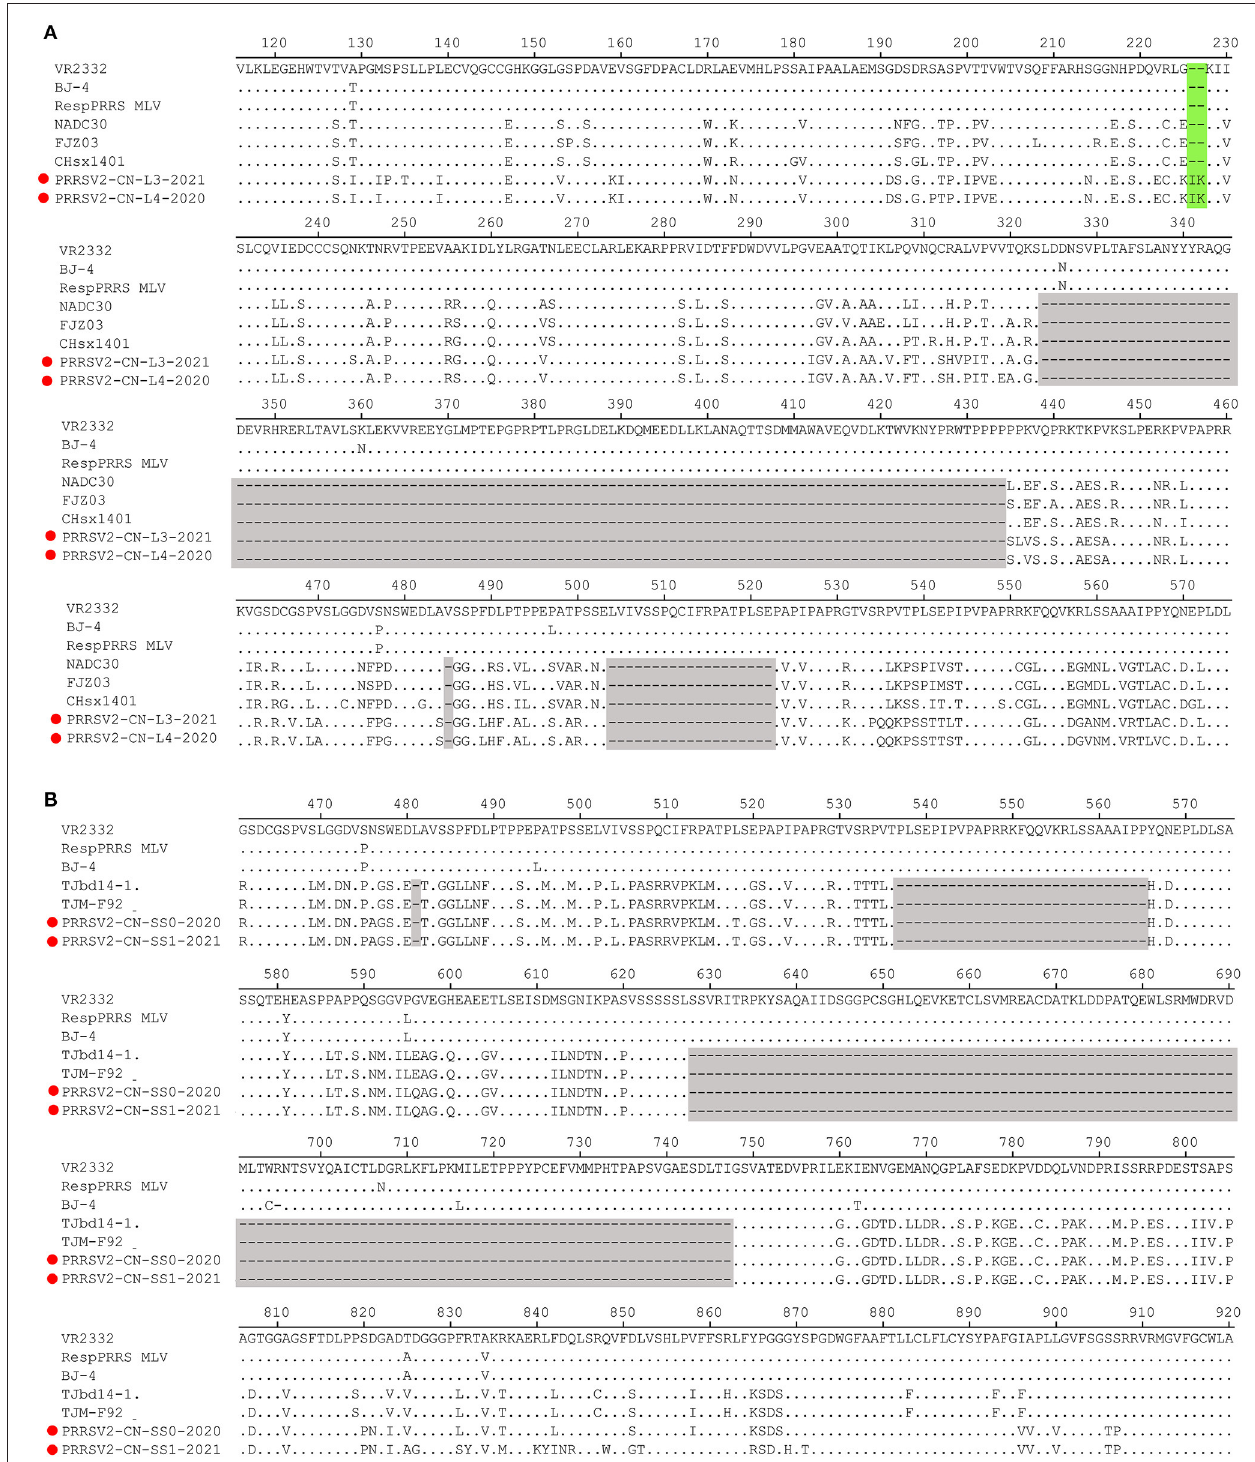
FIGURE 2 | Amino acids alignment for Nsp2 of the four PRRSV isolates with representative strains. (A) The 131-aa discontinuous deletions (aa324–434, aa485, and aa504–522) highlighted in gray boxes show the deletion signature of PRRSV2/CN/L3/2021, PRRSV2/CN/L4/2021, and NADC30-like strains. Additional 2-aa insertion in PRRSV2/CN/L3/2021 and PRRSV2/CN/L4/2021 is marked in the green box. (B) The 150-aa discontinuous deletions (aa481 + aa537-566 + aa628–747) highlighted in gray boxes show the deletion signature of PRRSV2/CN/SS0/2020, PRRSV2/CN/SS1/2021, and MLV TJM-F92 strain.